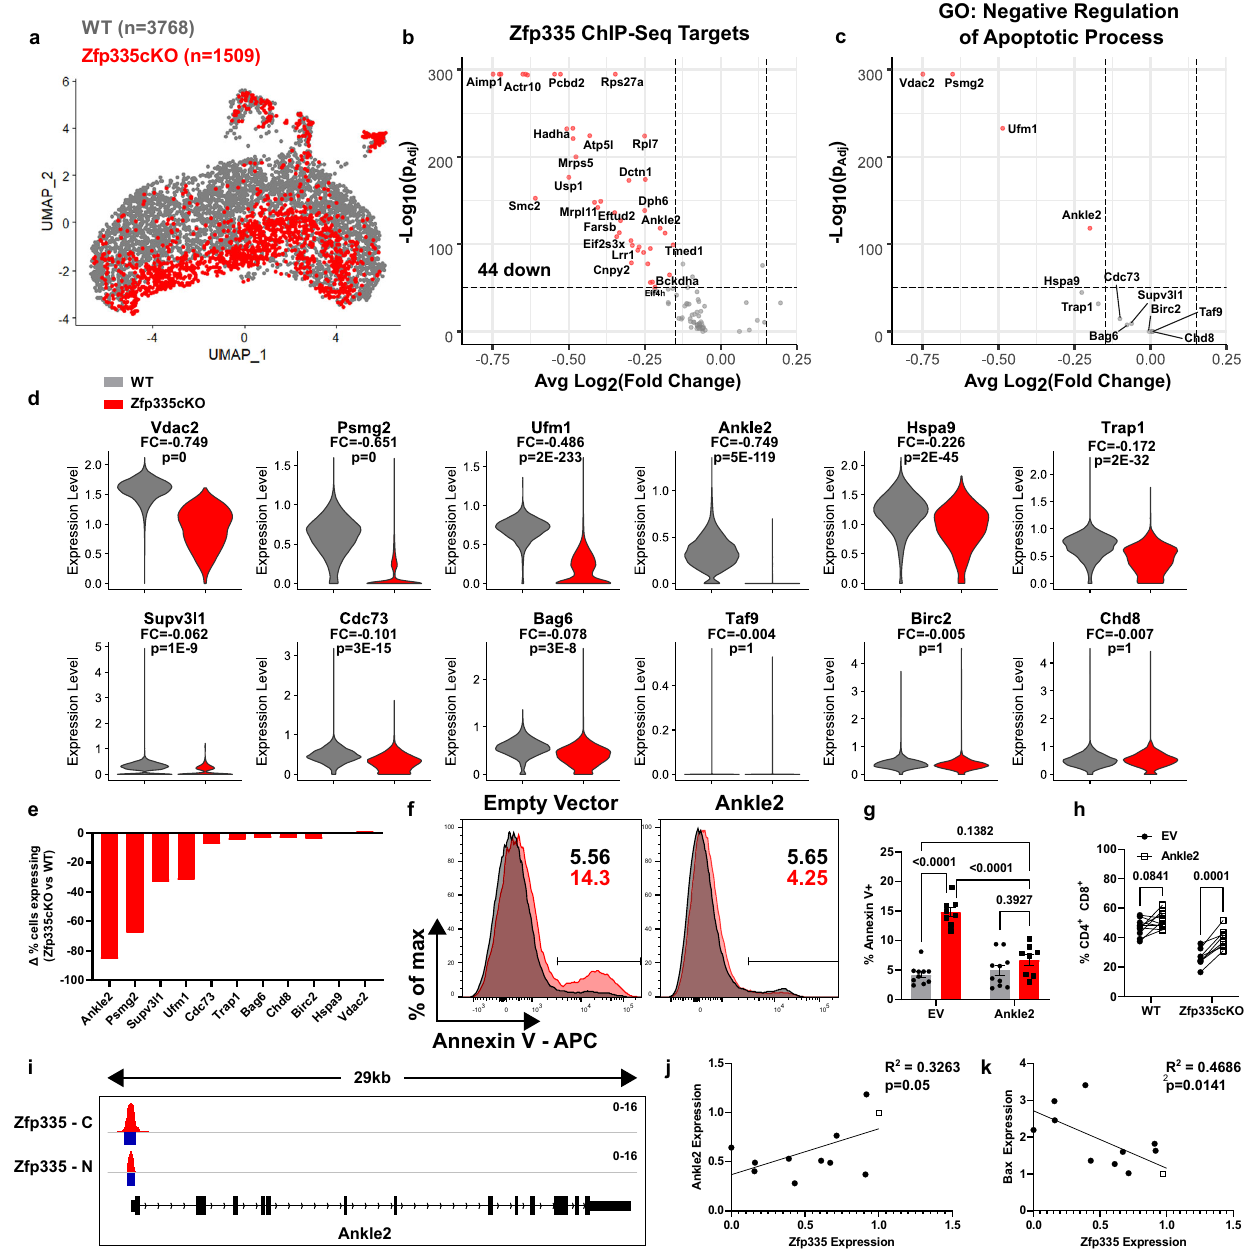
Fig. 5 | scRNA-seq identi fi es Ankle2 as a critical Zfp335-regulated gene con- trolling survival ofDN4 thymocytes. a UMAP projection of WT and ‘ true ’ Zfp335 mutant DN4 cells colored by genotype. Volcano plot of all differentially expressed Zfp335 target genes ( b ) or those experimentally shown negatively regulate apop- totic processes ( c ) between Zfp335 mutant and WT cells. d Violin plots of anti- apoptotic Zfp335 target gene expression between Zfp335 mutant and WT DN4 cells. FC indicates log 2 (Fold Change) between Zfp335cKO and WT, p indicates adjusted p -values. e Differential proportions of Zfp335 mutant cells expressing antiapoptoticgenesfrom c , d comparedtoWTcellsbasedondropout-imputation. Representative gating ( f ) and quanti fi cation of apoptosis ( g ) or DP cell frequency ( h ) for EV or Ankle2 retrovirus transduced WT ( n =10) or Zfp335cKO ( n =8) DN3